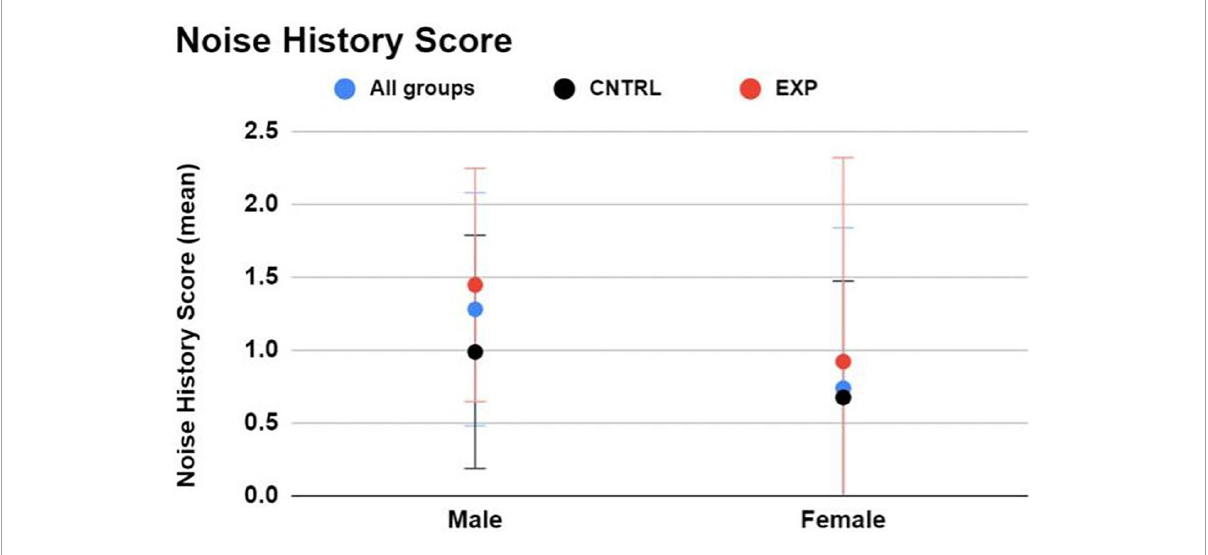
FIGURE2 The Noise Risk Calculator (https://knowyournoise.nal.gov.au/noise-risk-calculator) computes a score to indicate the user’s NIHL risk level from everyday, noisy activities reported by the user. The estimation excludes risk of firearm use from the formula. Between males and females, males exhibited a higher Noise History Score than females. Between firearm groups, EXP participants exhibited a higher Noise History Score than CNTRL participants. Figure shows mean and one standard deviation, with higher NIHL risk indicated by a higher